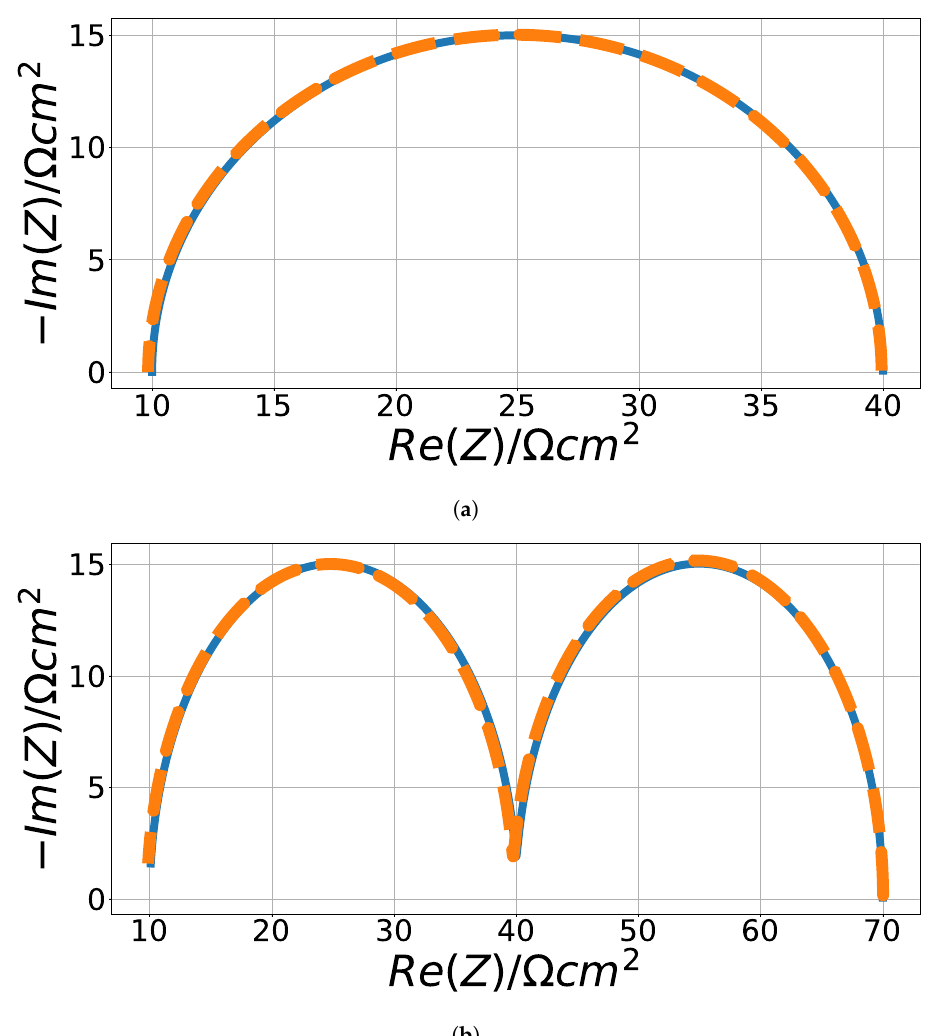
Figure 10. Randles circuit—matched impedance characteristic. ( a ) Single; ( b ) Double.